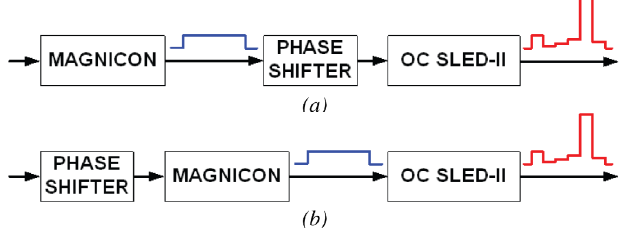
FIG. 12. (Color) Operation of OC SLED-II with a 180 (cid:7) phase flip: (a) phase shifter is installed at the input of the magnicon; (b) phase shifter is installed behind the magnicon.